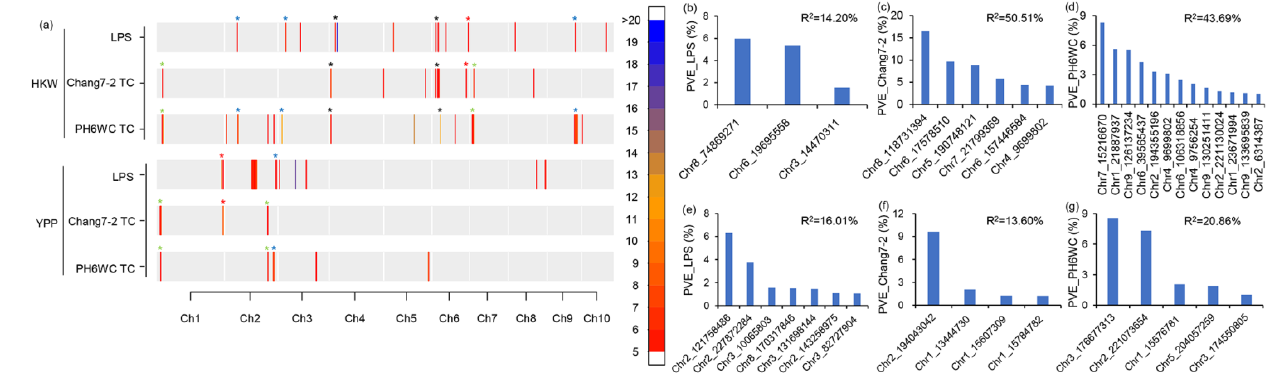
Figure 2. Distributions and effects of significant SNPs. ( a ) Distribution of significant SNPs control- ling each trait of each population; the colors show the density of significant SNPs within a 1 Mb interval; red asterisk indicates common QTL between LPS and Chang7-2 TC populations; blue asterisk indicates common QTL between LPS and PH6WC TC populations; green asterisk indicates common QTL between Chang7-2 TC and PH6WC TC populations; dark asterisk indicates common QTL among LPS, Chang7-2 TC and PH6WC TC populations. ( b – d ) PVE of the large-effect SNPs controlling HKW of the LPS, Chang7-2 and PH6WC TC populations, respectively. ( e – g ) PVE of the large-effect SNPs controlling YPP of the LPS, Chang7-2 and PH6WC TC populations, respectively. In ( b – g ), only SNPs with PVE larger than 1% are shown; PVE_LPS, PVE_Chang7-2 and PVE_PH6WC indicate phenotypic variance explained by the significant SNPs in the LPS, Chang7-2 and PH6WC TC populations,